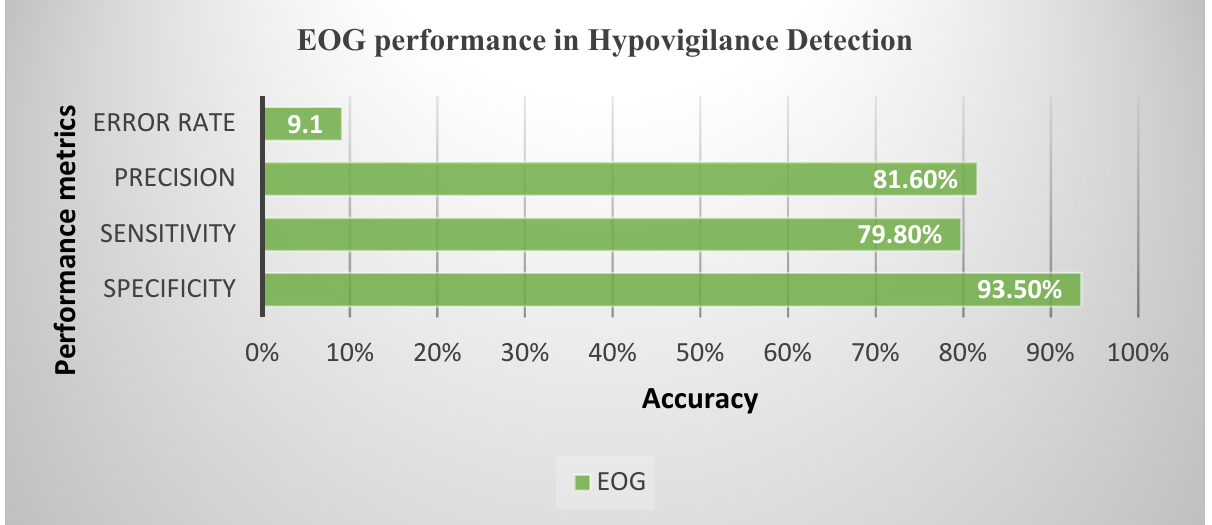
Figure 8 . EOG performance metrics for hypovigilance detection. Figure 8. EOG performance metrics for hypovigilance detection.